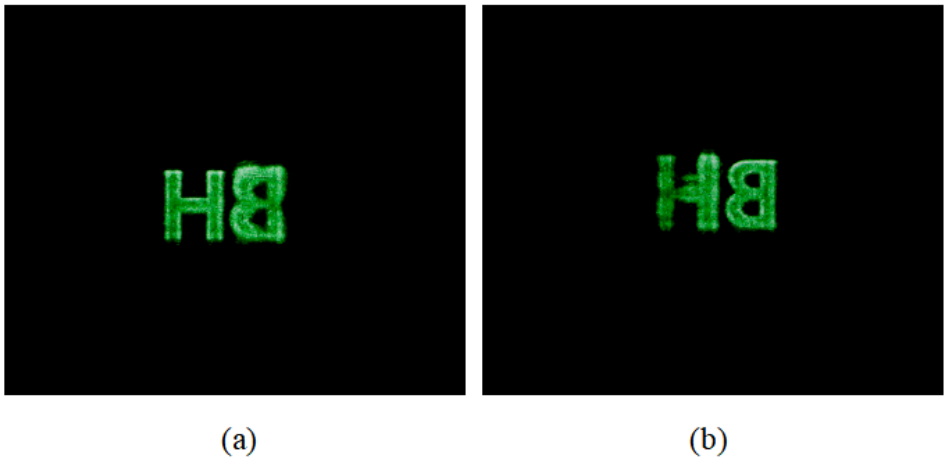
Figure 8. Results of the reconstructed 3D image by using the proposed system. ( a ) Result when “H” is focused; ( b ) result when “B” is focused.